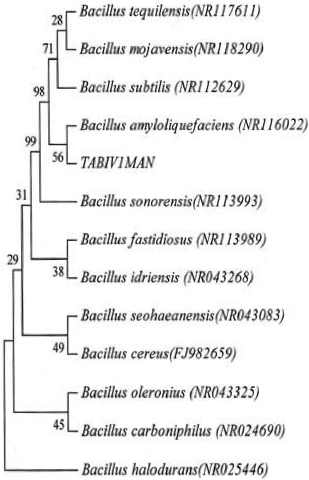
FIGURE 4 - Neighbor-joining tree based on 16S rRNA (1600) sequences showing the relationship between unknown isolate TABSIV1MAN and other closely related species of the genus Bacillus